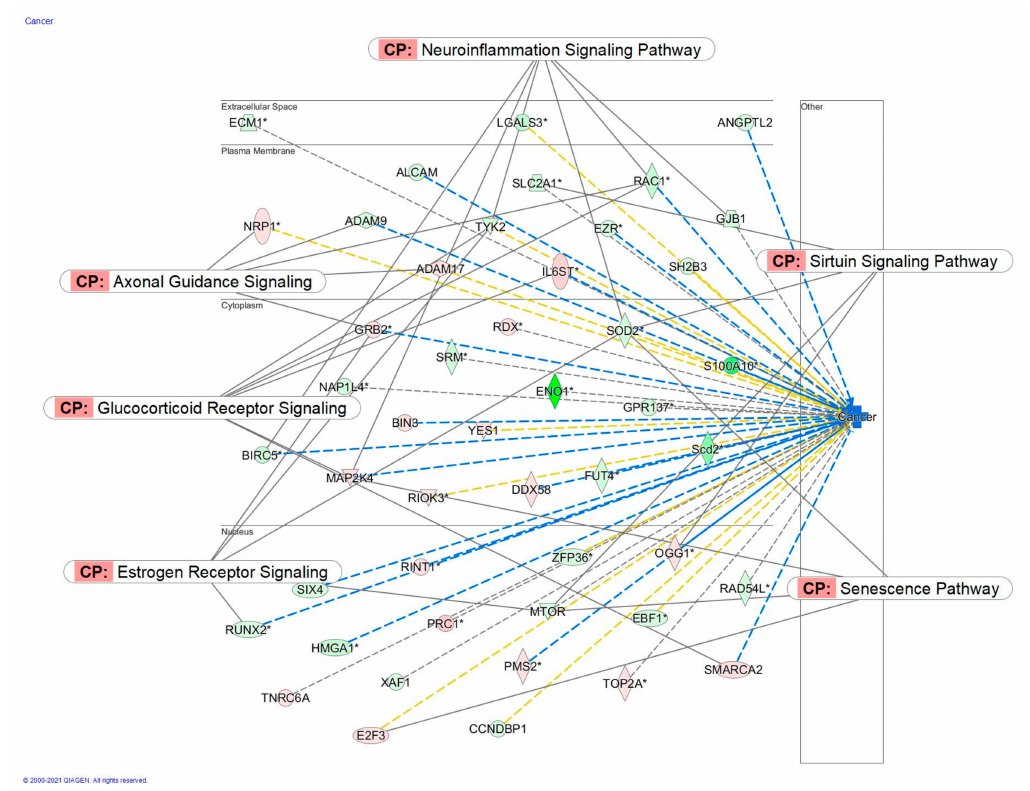
Figure 22. Predicted effects of Rg5 in cancer: predicted inhibition (blue) at the concentration of 100 nM. *: Results from Network Pharmacology of Red Ginseng (Part